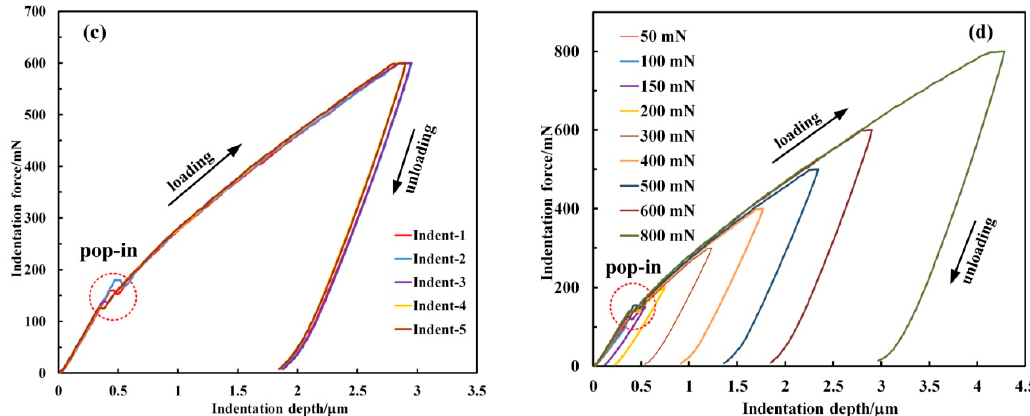
Figure 3. Indentation force-depth ( F – h ) curves. ( a , c ) are the five repeated F – h curves with peak force of 600 mN under the Berkovich and flat-tip indentation, respectively. ( b , d ) are the averaged F – h curves at different peak forces with the Berkovich and flat-tip indenters, respectively. Each single curve in ( b , d ) was obtained from the averaged data of the five repeated F – h curves at corresponding force.